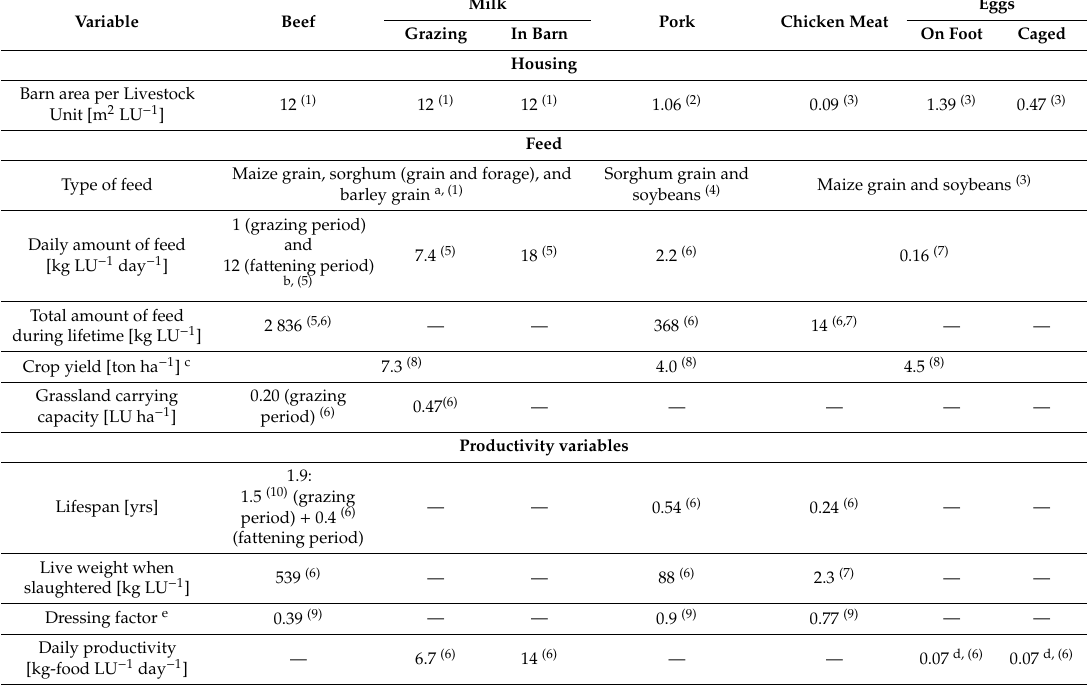
Table 4. Variables that determine the LRAP for the livestock production systems. Data sources: (1) [16]; (2) calculations with Equation (8) using [21]; (3) [22]; (4) [20]; (5) calculations by the authors using [19]; (6) calculations by the authors using [17]; (7) [23]; (8) calculations by the authors using FAO statistics [7]; (9) calculations by the authors; (10) assumption for this